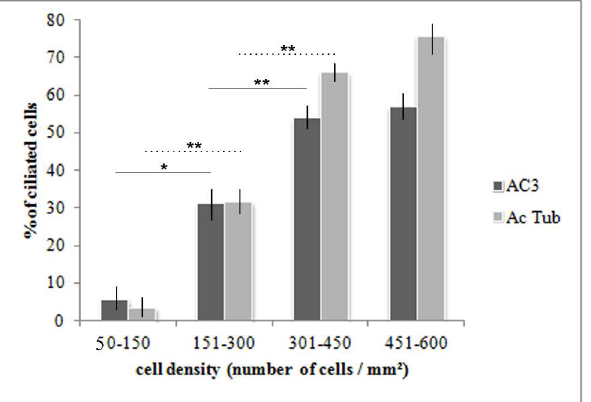
Fig 4. AC3-positive cilia in fibroblast culture. There is an increasingnumberof fibroblastsextendingan AC3 positive cilium with increasing cell confluence. Values represent means ± SEM ( * p < 0.05; ** p < 0.01). Solid lines concernAC3 and dotted lines concernacetylatedtubulin.Abbreviations: AC3: adenylate cyclase type III; Ac Tub: acetylated-tubulin.